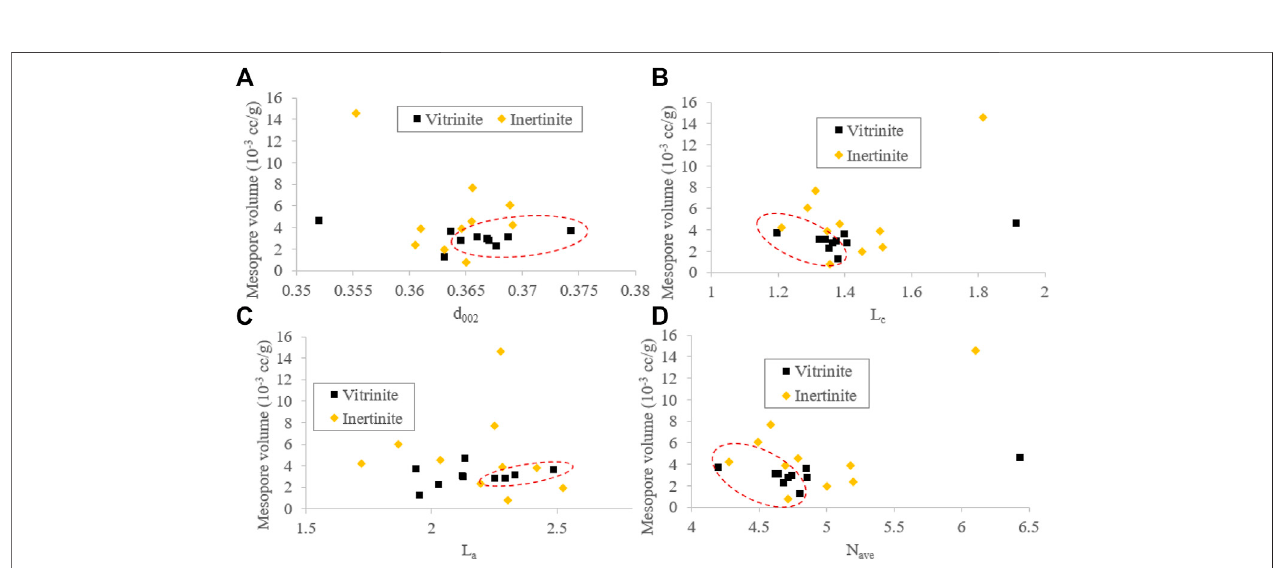
FIGURE 10 | Relationships between the mesopore volume and XRD parameters (d 002 (A) , L c (B) , L a (C) , and N ave (D) ).